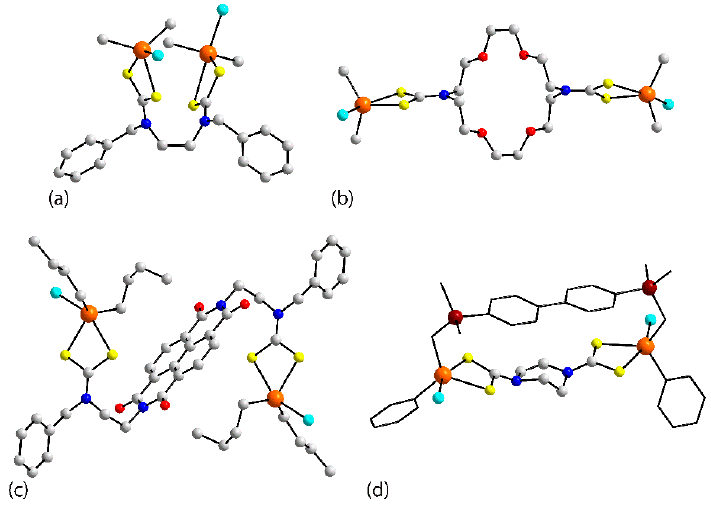
Figure 16. Molecular structures of ( a ) (Me 2 SnCl) 2 (L 1 ) in the crystal of 67 , ( b ) (Me 2 SnCl) 2 (L 33 ) in 68 , ( c ) [(nBu) 2 Sn] 2 (L 35 ) in 73 , and ( d ) [PhSn(Cl)CH 2 Si(Me) 2 C 6 H 4 C 6 H 4 Si(Me) 2 CH 2 Sn(Ph)Cl](L 2 ) in 77 .